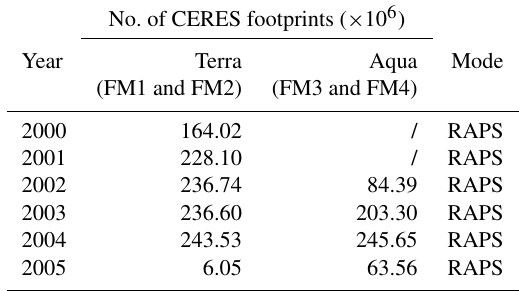
Table 1. Number of CERES footprints obtained after screen- ing for marine clouds. Number are shown in millions (in total 1711937663